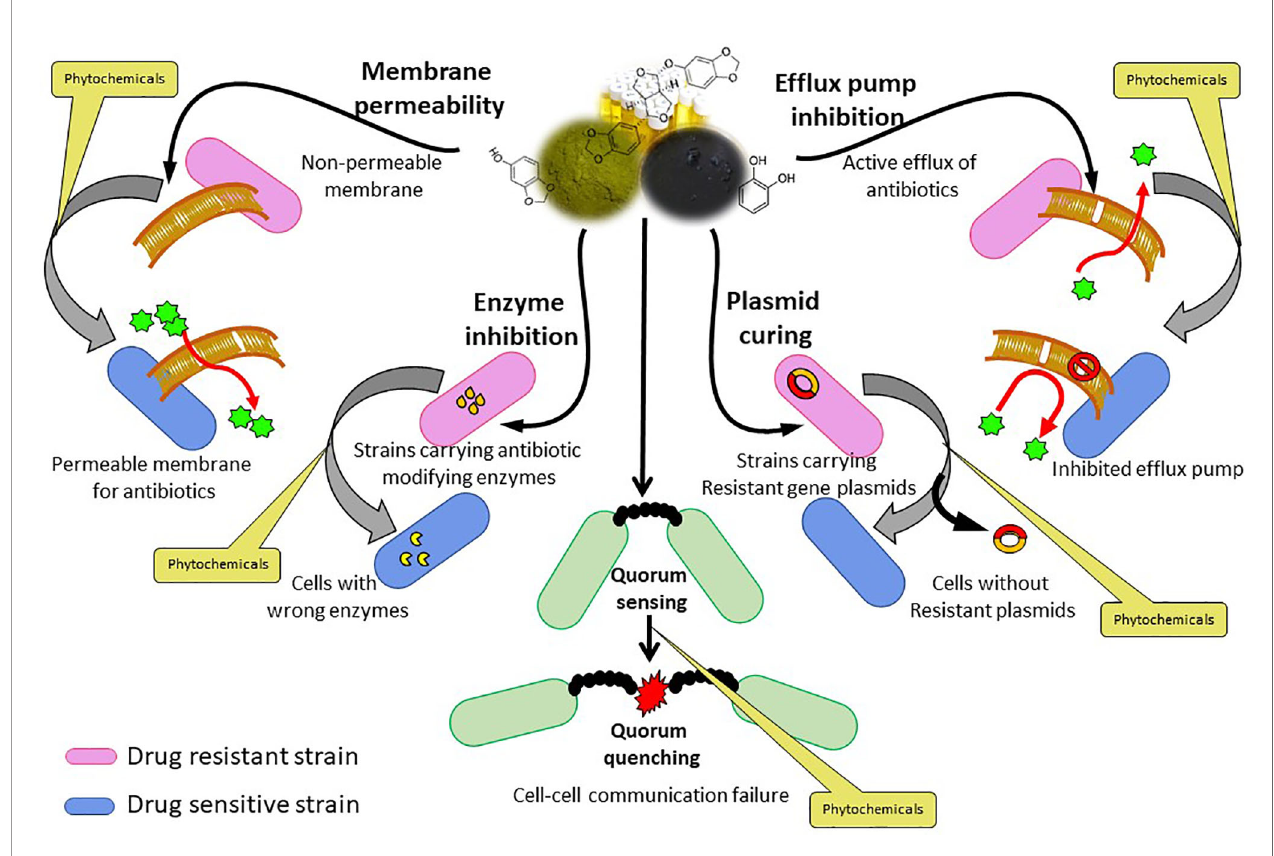
FIGURE 2 | Phytochemicals conferring various bacterial resistance